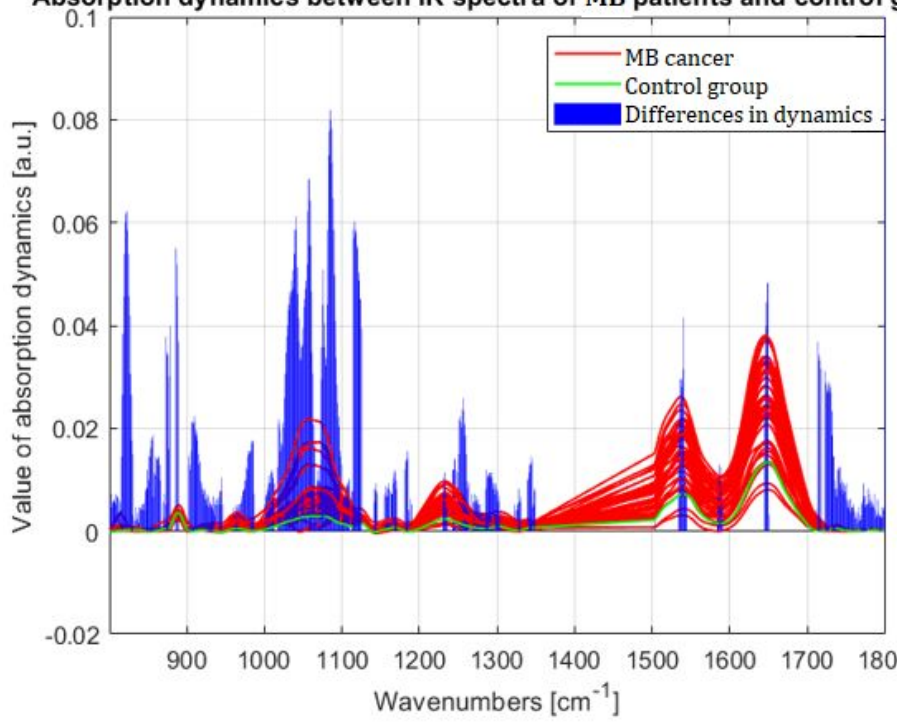
Figure 5. Graphical presentation of differences in absorption dynamics between the medulloblastoma patients and the control group in the region 800–1800 (cm − 1 ) of wavenumbers (resected region of lipids 1350–1500 (cm − 1 )). The red line presents the spectra for medulloblastoma patients, the green the average for control group, and the blue vertical bars represent the summarized, normalized difference in absorbance dynamics between medulloblastoma patients and the control group. Table 4. Regions of wavenumbers, which can be used as potential markers to discriminate medulloblas- toma patients by IR spectrum with discrimination probability. Values > 80% are shown in